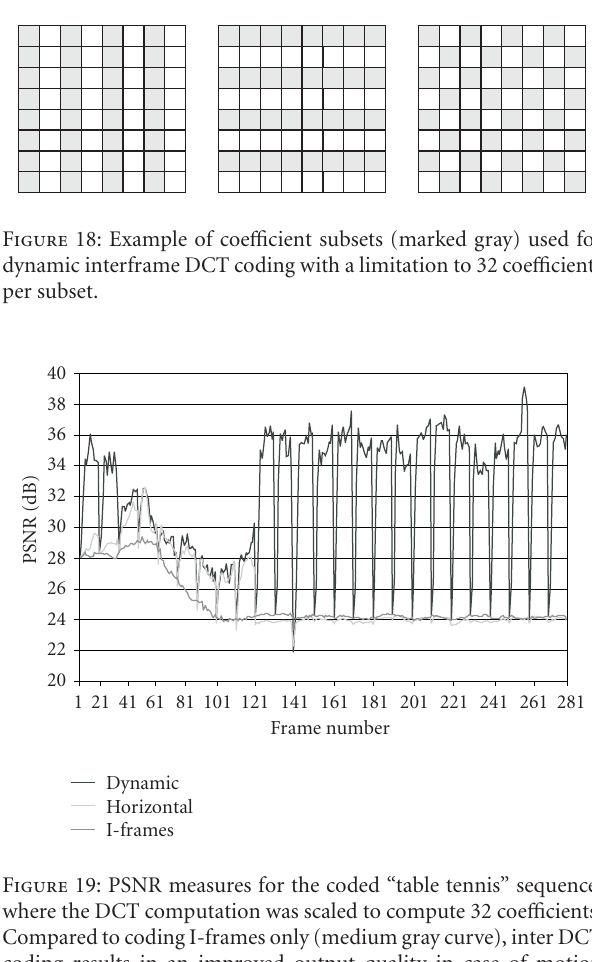
Figure 17: Visualization of a phenomenon from the scalable DCT, leading to a gradual quality increase over time.